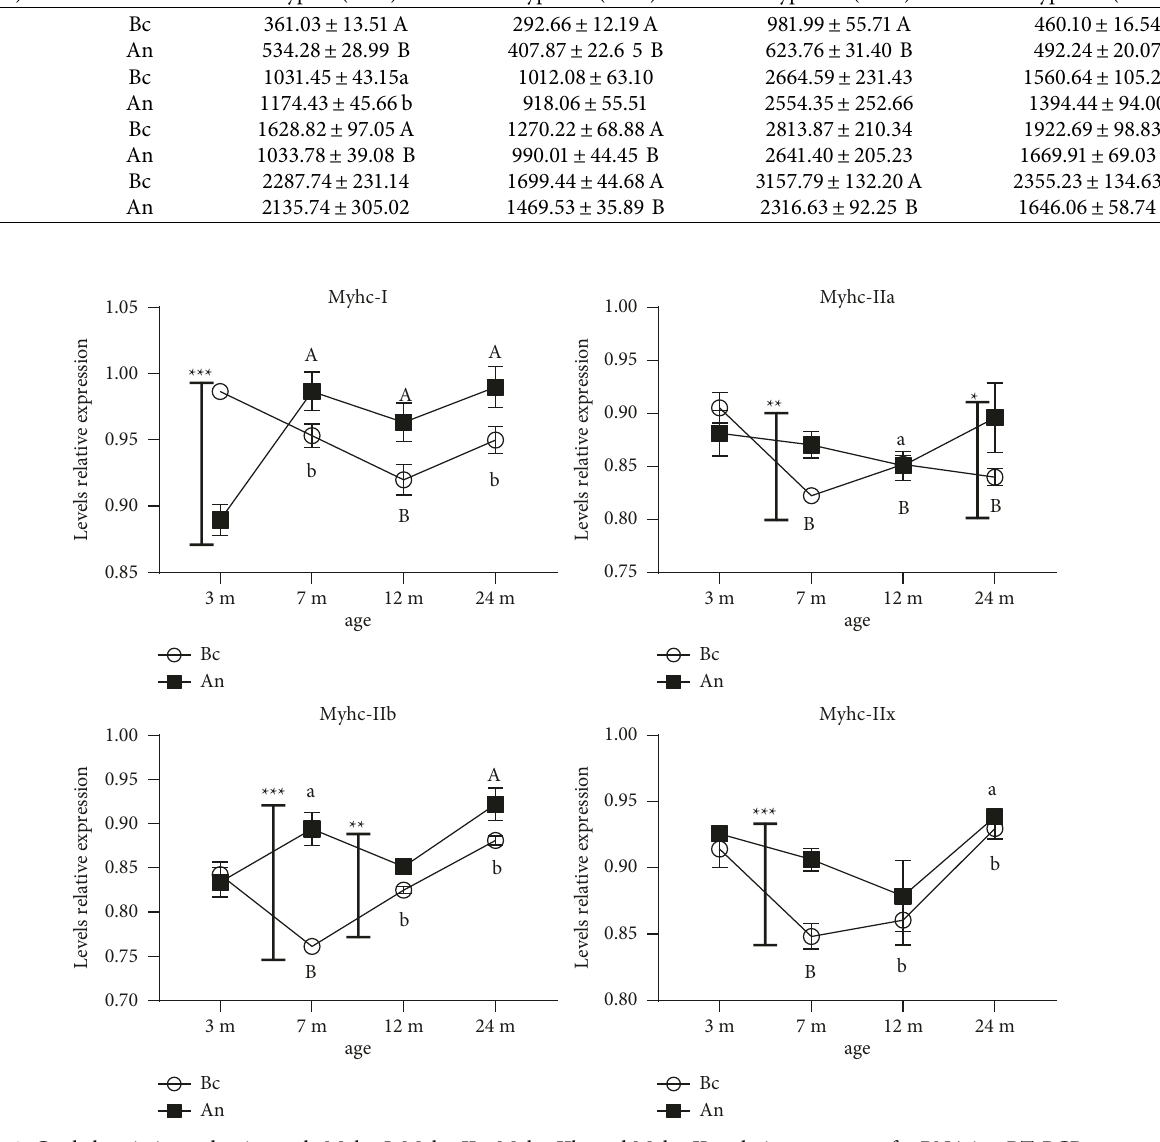
Figure 3: Cattle longissimus dorsi muscle Myhc-I, Myhc-IIa, Myhc-IIb, and Myhc-IIx relative amounts of mRNA in qRT-PCR comparing the expression of two breeds 3, 7, 12, and 24 months. The x-axis represents the age of the cow, and the y-axis represents the expression level of the four muscle